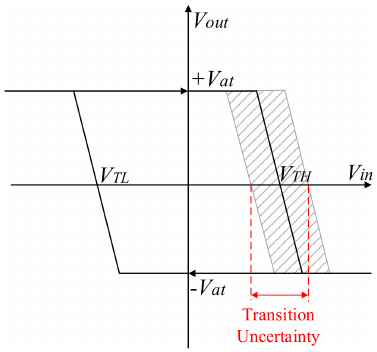
Figure 15. First-order model with input offset voltage and